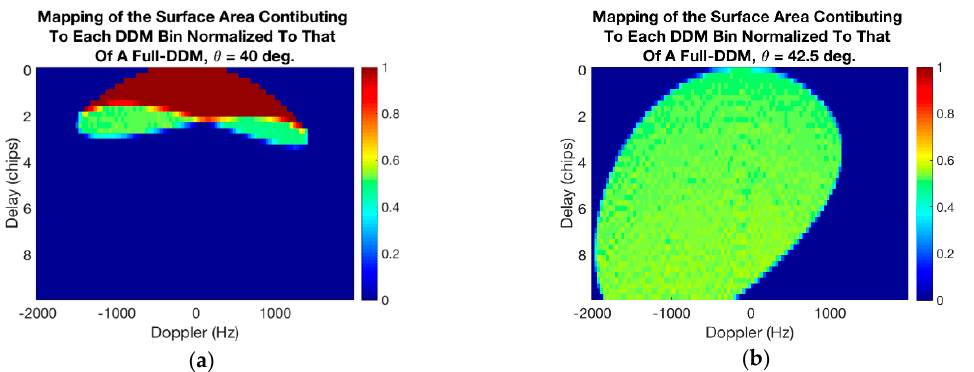
Figure 12. Spatially filtered effective surface scattering area used for ( a ) 40° and ( b ) 42.5° incidence angle.